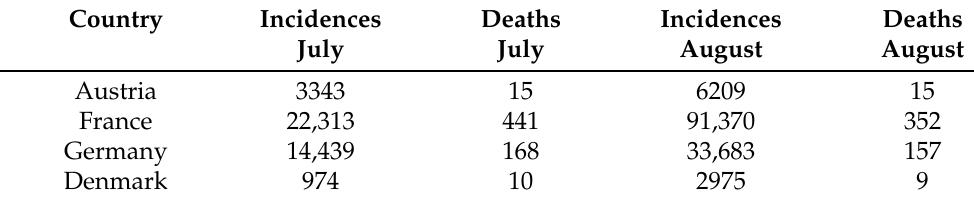
Table 3. COVID-19 incidences and related deaths in July and August 2020 for four countries. Although the incidences increased significantly, the related deaths did not. Below a certain threshold, incidences and deaths are not necessarily connected (“uncoupling” of incidences and deaths). Country Incidences Deaths Incidences Deaths July